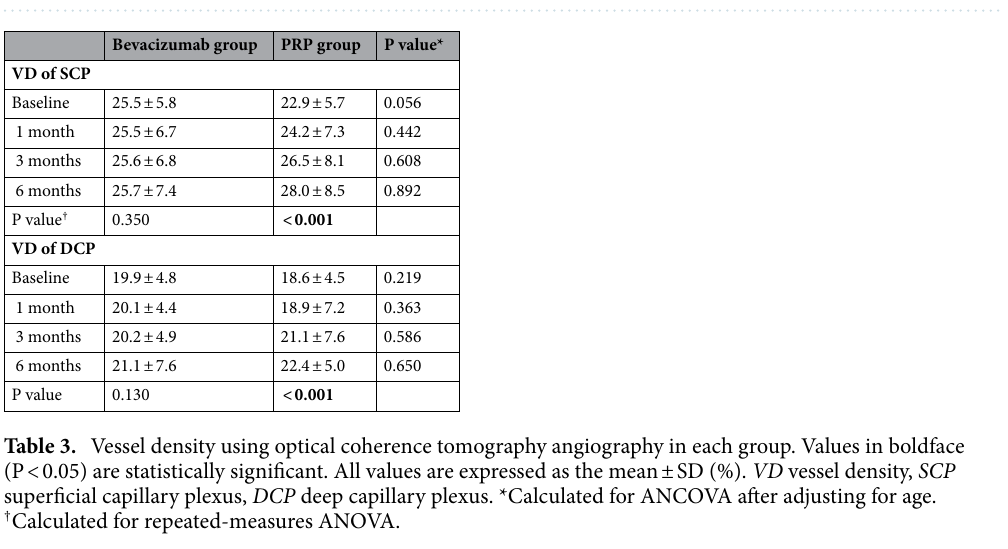
Figure 3. Representative optical coherence tomography images of baseline and final inner retinal layer thickness in each group. Baseline inner retinal layer thickness of bevacizumab group ( A ) showed a tendency to decrease at final visit ( B ), whereas baseline thickness of PRP group ( C ) increased at final visit ( D ). Thicknesses according to the ETDRS circle in each image are thickness of retinal nerve fiber layer (RNFL), ganglion cell layer (GCL), and inner plexiform layer (IPL), respectively. Red line: internal limiting membrane, green line: RNFL, puple line: GCL, blue line: IPL.